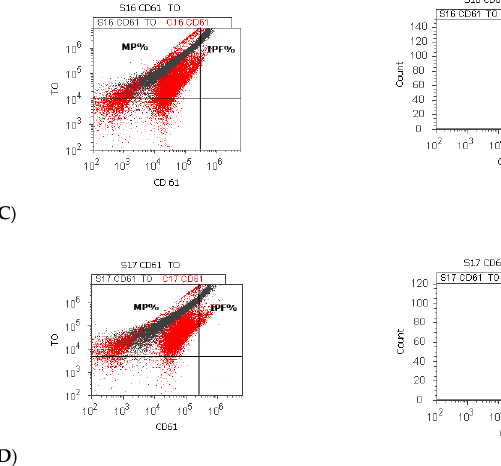
Figure 1. Blood-cell analysis of the immature platelet fraction (IPF) by CD 61 platelet membrane glycoproteins and thiazole orange stain (TO), performed by the Attune Acoustic focusing cytometer, Life Technologies, the USA, equipped with the Attune Cytometric Software v.1.2.5, Applied Biosys- tems, 2010. ( A ) Healthy full-term newborn with normal IPF; ( B ) Preterm newborn with respiratory distress syndrome with the need for respiratory support (RDS+) and intraventricular bleeding (IVH+) with low IPF; ( C ) Preterm newborn with anemia of prematurity (AoP+) with low IPF; ( D ) Preterm newborn with respiratory distress syndrome with the need for respiratory support (RDS+) with low IPF; ( 1 ) Dot plot by control extrapolation (CD61) on graphic; ( 2 ) Histogram plot by IPF% extrapolating on CD61 axis; ( 3 ) Density plot with quantification of immature platelet fraction (IPF%) and mature platelets (MP%) by highlighting the double-positive stained platelets population represented by IPF.